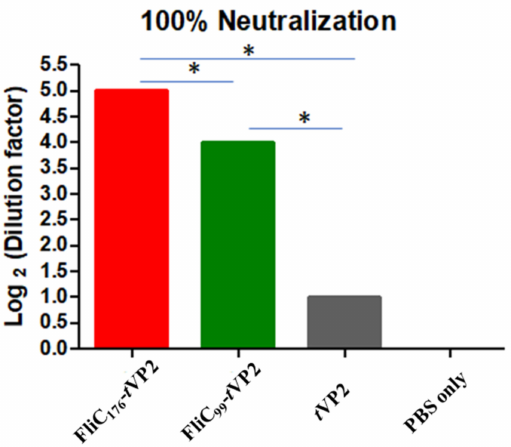
Figure 7. Serum samples were taken from the chicken (number of chickens in each group = 3), and 100 TCID50 of the virus was used to check the neutralization activity of the antibody. Data are presented as mean ± SEM, and the t -test showed a significant difference ( p < 0.05) between different groups. *. Indicate the significant differences ( p < 0.05) between treatment groups at the same time